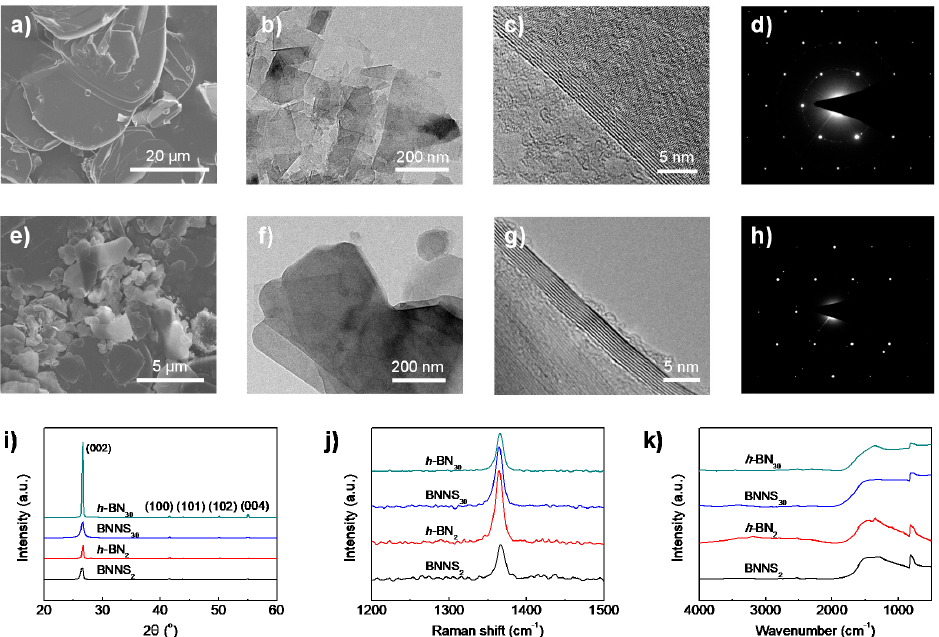
Figure 1. Morphology and microstructure of raw hexagonal boron nitride ( h -BN) materials and exfoliated boron nitride nanosheets (BNNSs). Scanning electron microscopy (SEM) images of ( a ) h -BN 30 and ( e ) h -BN 2 raw materials. Transmission electron microscopy (TEM) images of ( b – d ) BNNS 30 and ( f – h ) BNNS 2 . The di ff raction spots in TEM ( d , h ) showed a typical hexagonal lattice. ( i ) X-ray di ff raction (XRD), ( j ) Raman spectroscopy, and ( k ) Fourier transformation infrared spectroscopy (FTIR) spectroscopy of pristine h -BN and exfoliated